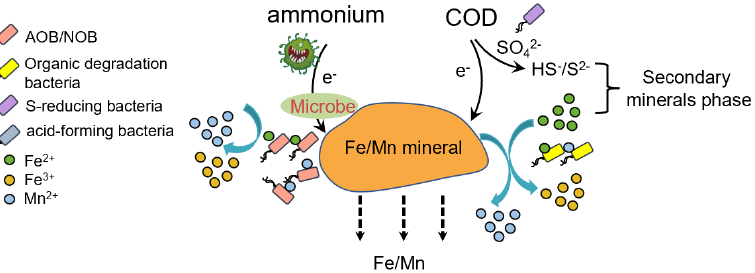
Figure 6. Effects of microbes, ammonium, and COD on the release of Fe and Mn from sediments.